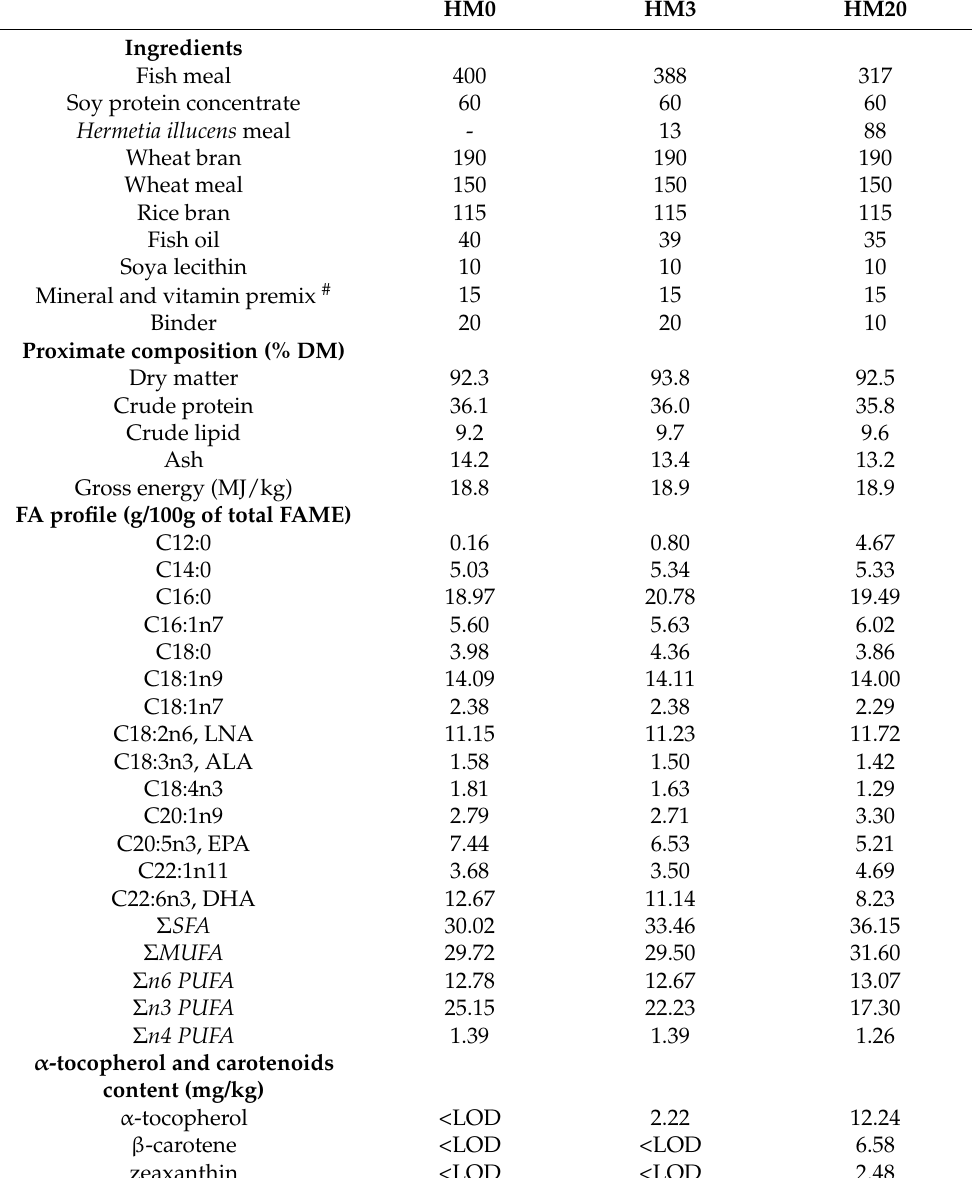
Table 1. Ingredients (g/kg as a fed-basis), proximate composition (% on dry matter, DM), fatty acids profile, and α -tocopherol and carotenoid content of the test